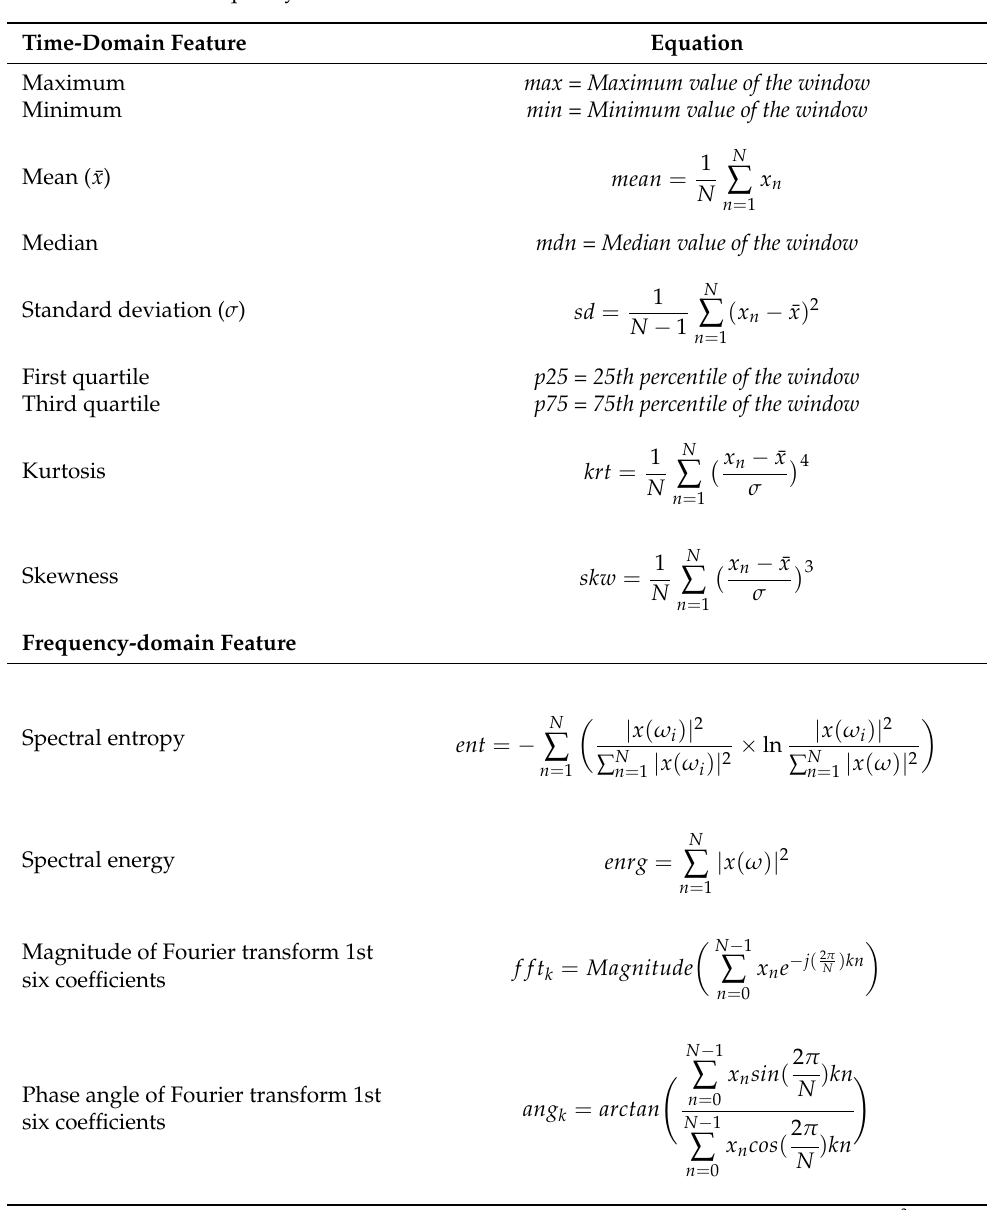
Table 1. Time- and frequency-domain